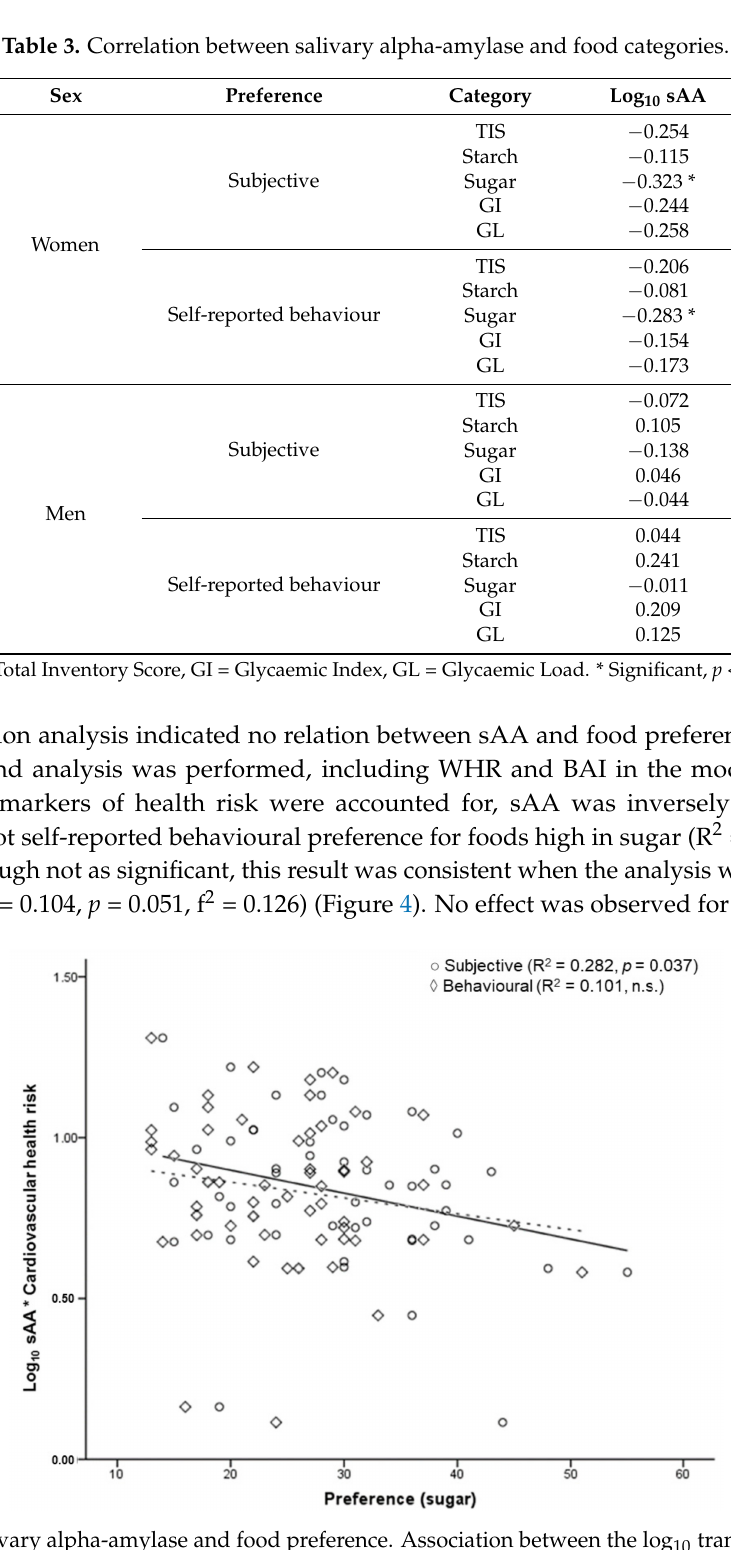
Figure 4. Salivary alpha-amylase and food preference. Association between the log 10 transformed sAA values and WHR in terms of subjective preference for foods high in sugar (in women). The straight line represents the line of best fit of the subjective category. The dotted line represents the line of best fit of the behavioural